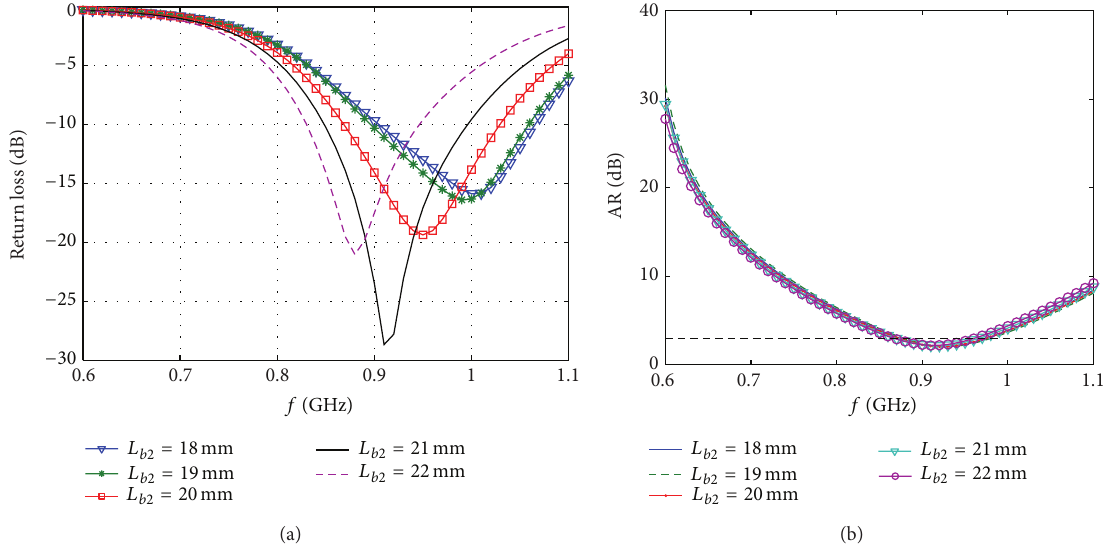
Figure 8: Comparison of S11 and AR of the antenna with different 𝐿 𝑏2 . (a) S11. (b) Axial